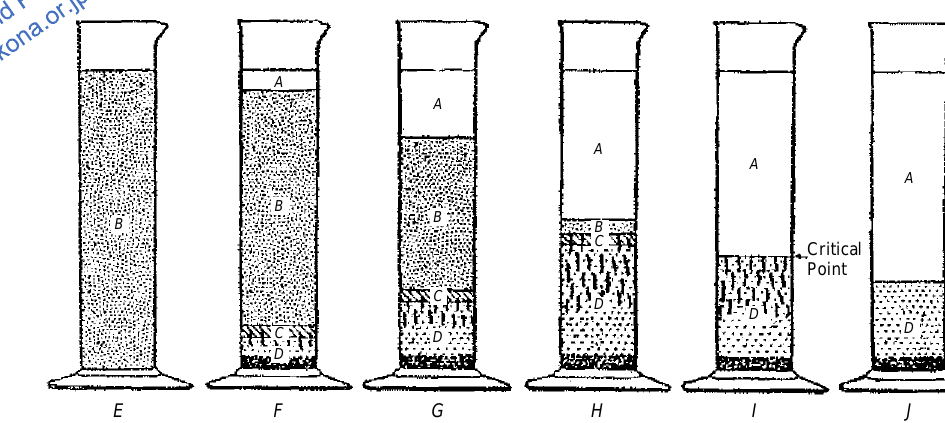
Settling of a flocculent suspension as illustrated by Coe and Clevenger (1916), showing the clear water zone ( A ), the zone in which the suspension is at its initial concentration ( B ), the transition zone ( C ) and the compression zone ( D